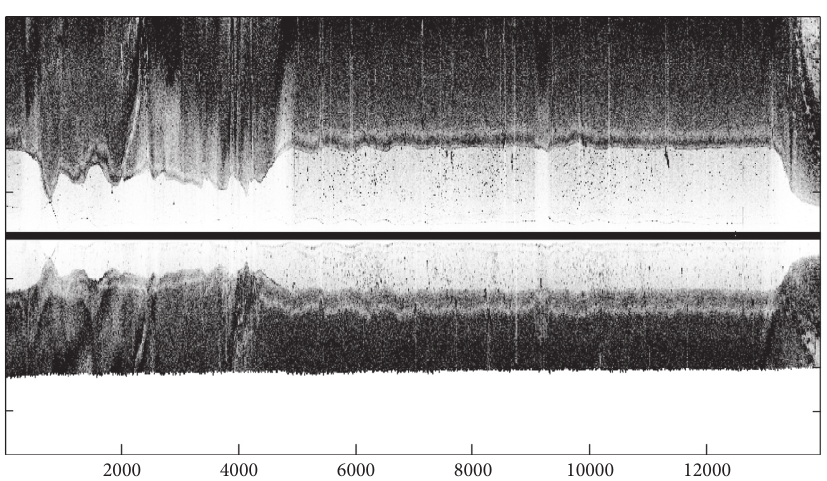
Figure 3: Echo data of a single ping scan